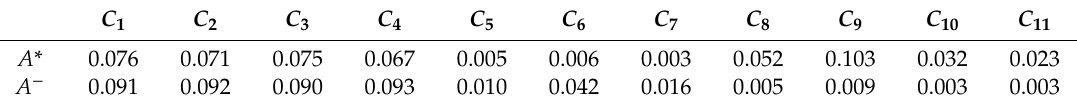
Table 12. Ideal Solution A * and Negative-Ideal Solution A − .